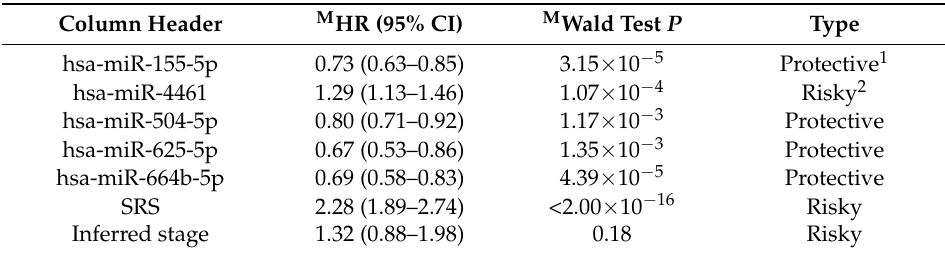
Table 2. Independent prognostic miRNAs for MCM patients based on